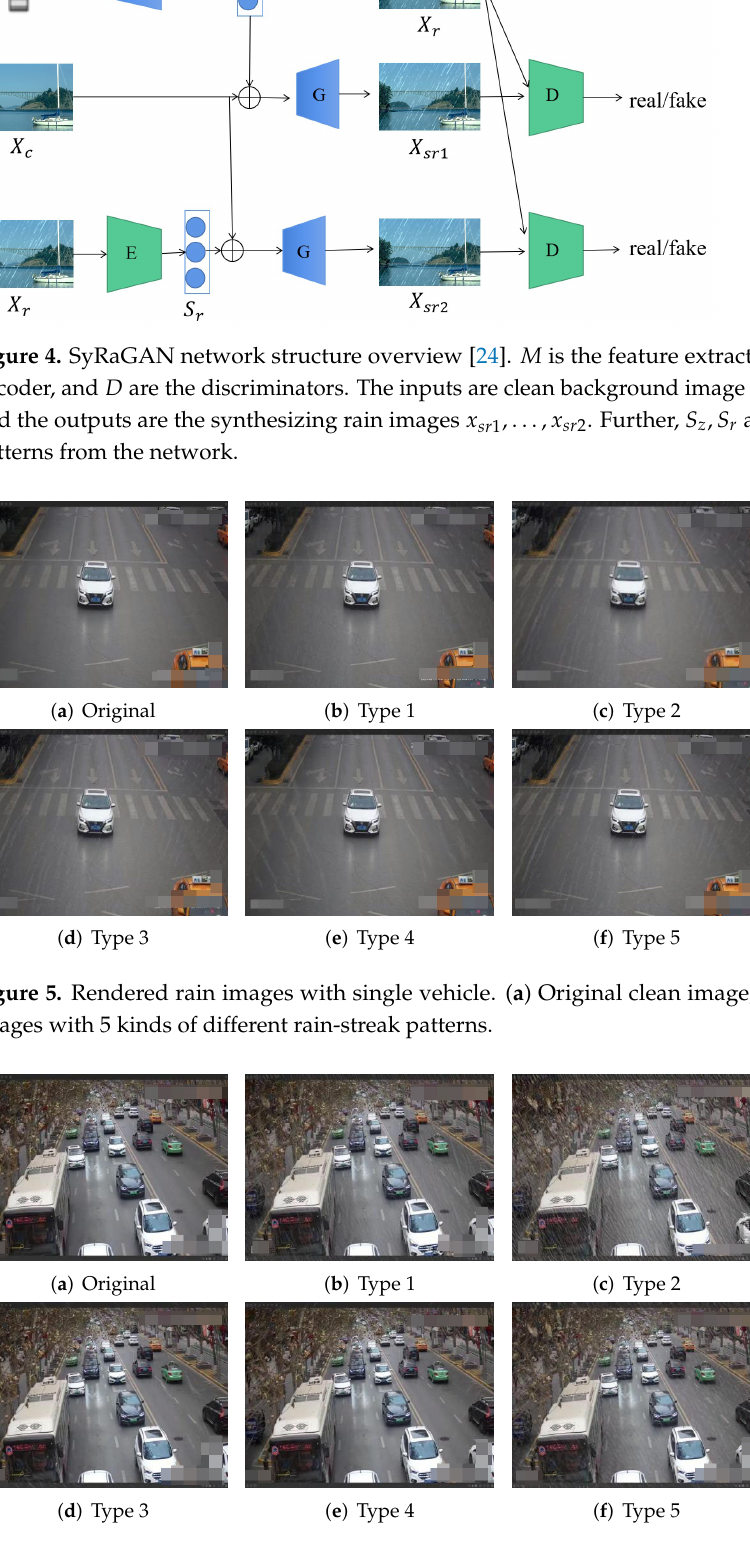
Figure 6. Rendered rain images with many vehicles. ( a ) Original clean image; ( b – f ) rendered rain images with 5 kinds of different rain-streak